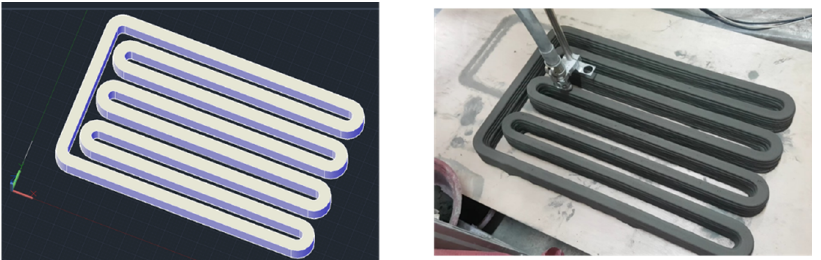
Figure 1. Three-dimensional model in CAD environment and concrete extrusion along the print path.